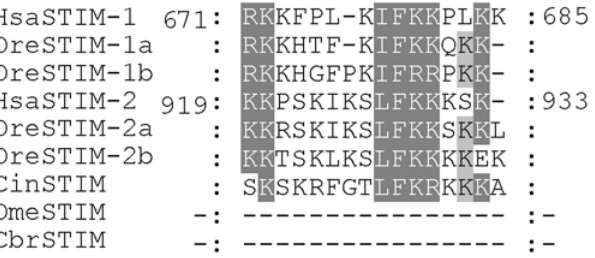
Figure 3. Sequence alignment of the lysine-rich domain from representative species. Shown is the sequence alignment of the lysine-rich domain of STIM molecules, which are numbered according to human STIM-1 and